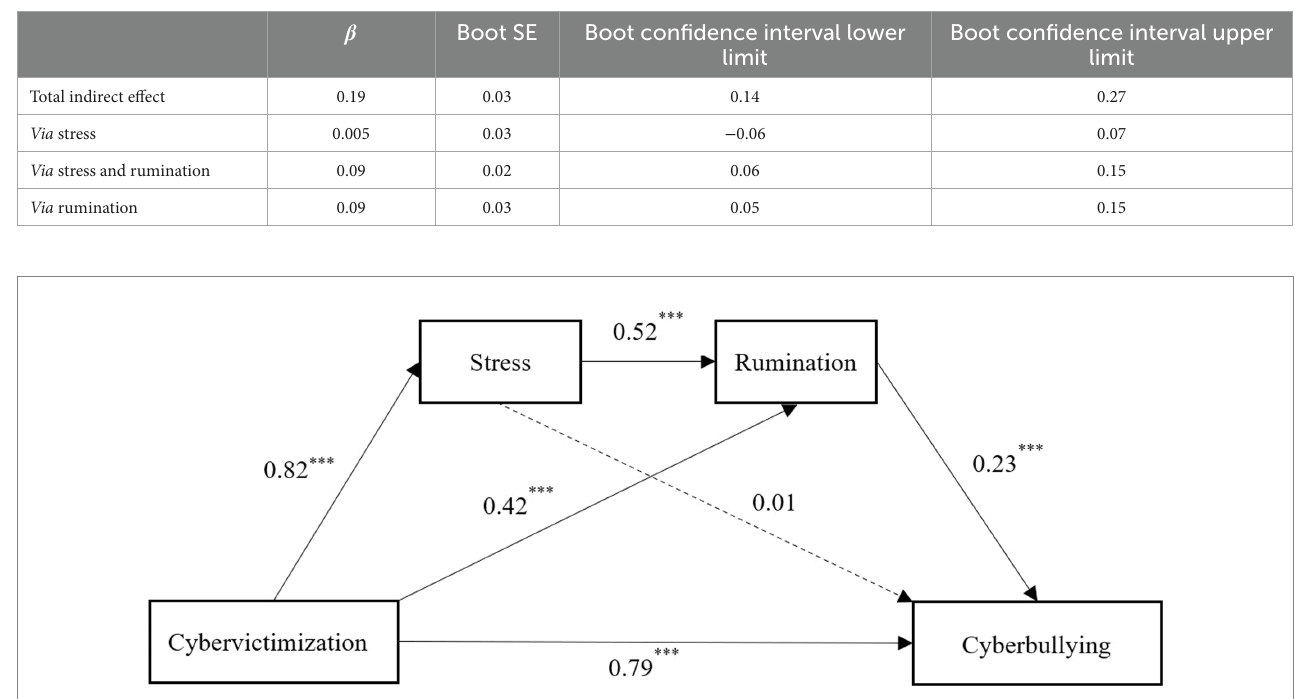
TABLE 3 Standardized indirect effects from stress and rumination.